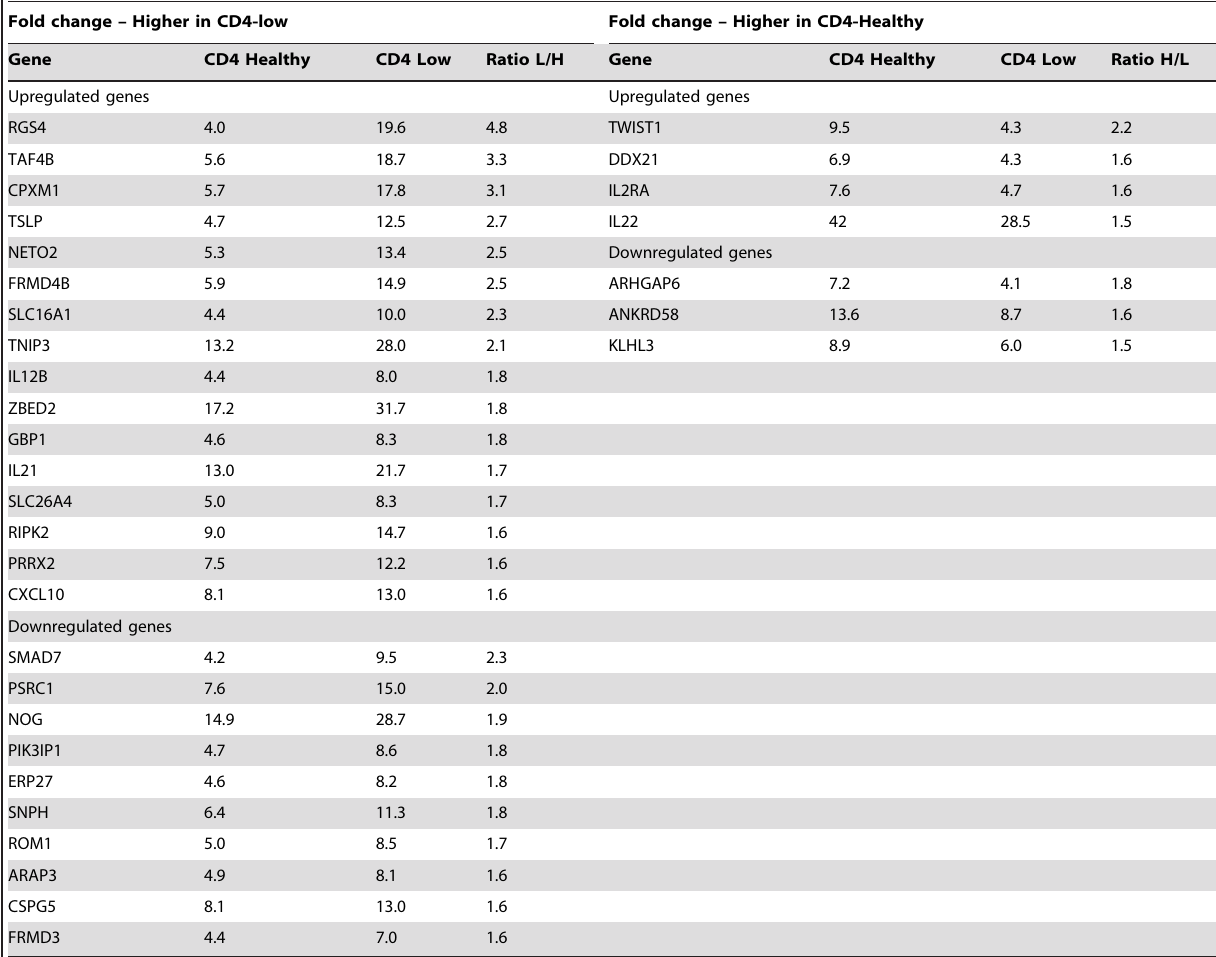
Fold change – Higher in CD4-low